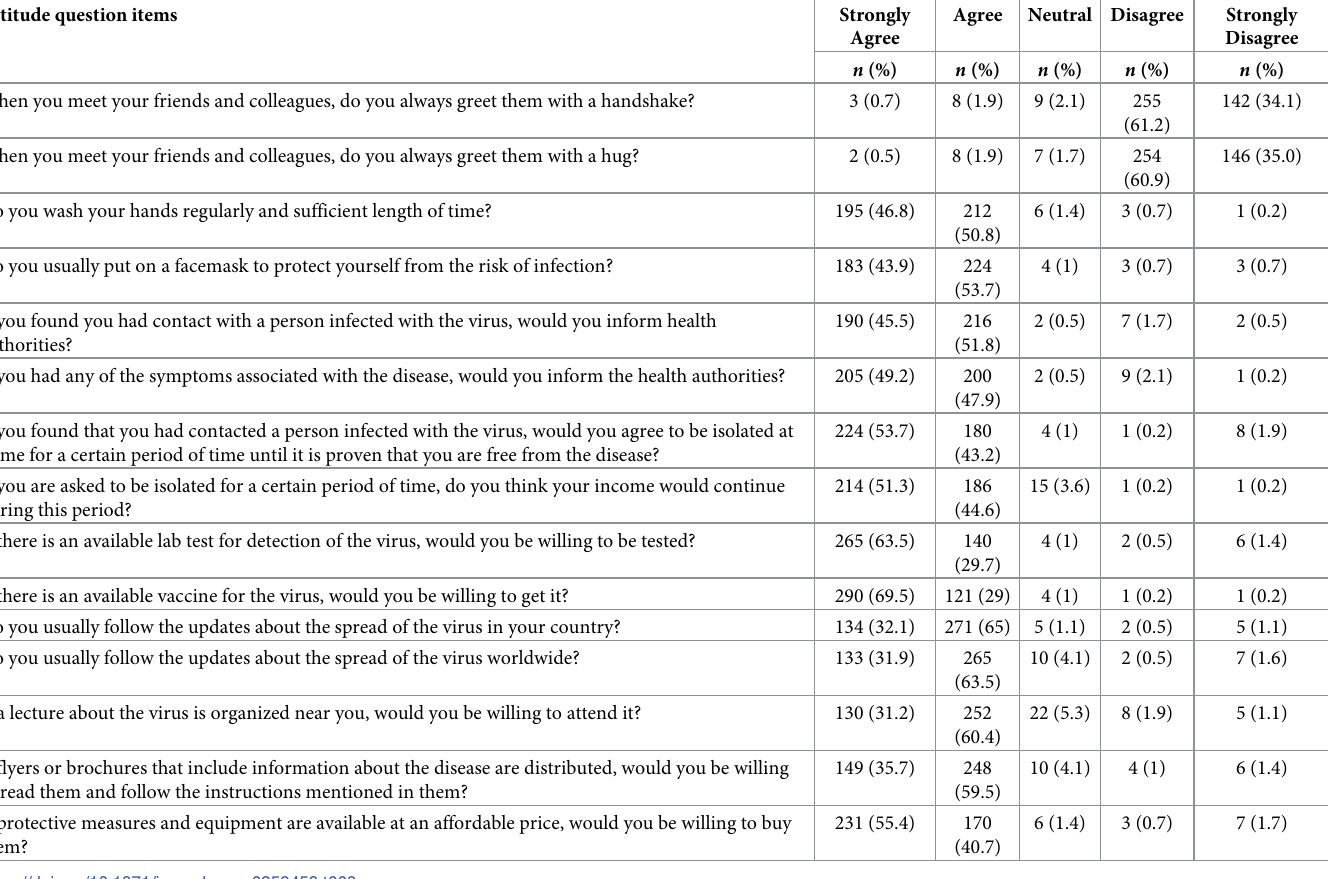
Table 3. Attitude towards COVID-19 among taxi drivers in Dessie City and Kombolcha Town, Ethiopia, July to August 2020. Attitude question items Strongly